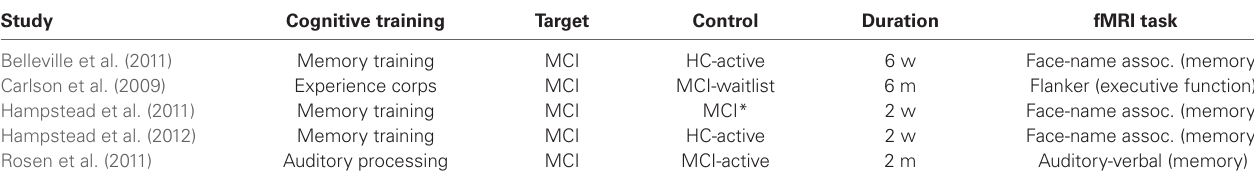
Auditory-verbal